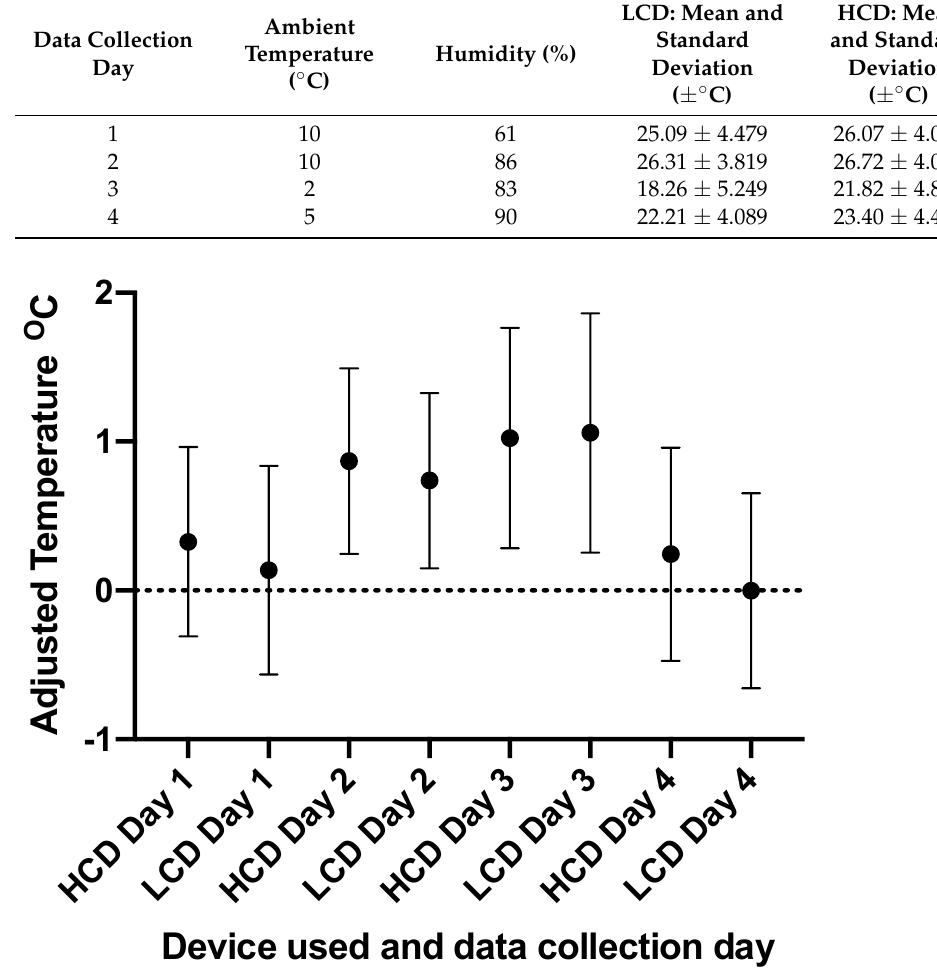
Figure 5. A graph showing the mean and 95% confidence interval of the temperature of cattle feet, once adjusted for ambient temperature, across each data collection day (n = 160, 164, 166, and 158 for data collection from each device on days 1–4, respectively) collected by the CAT S62-Pro Smartphone (LCD) and FLIR T620bx (HCD). The adjusted temperatures were calculated from the residuals from the average healthy foot temperature on each data collection day. The dotted line at 0 represents foot temperatures equivalent to the average temperature of healthy feet for the corresponding day of data collection. No data groups were statistically significant from each other.